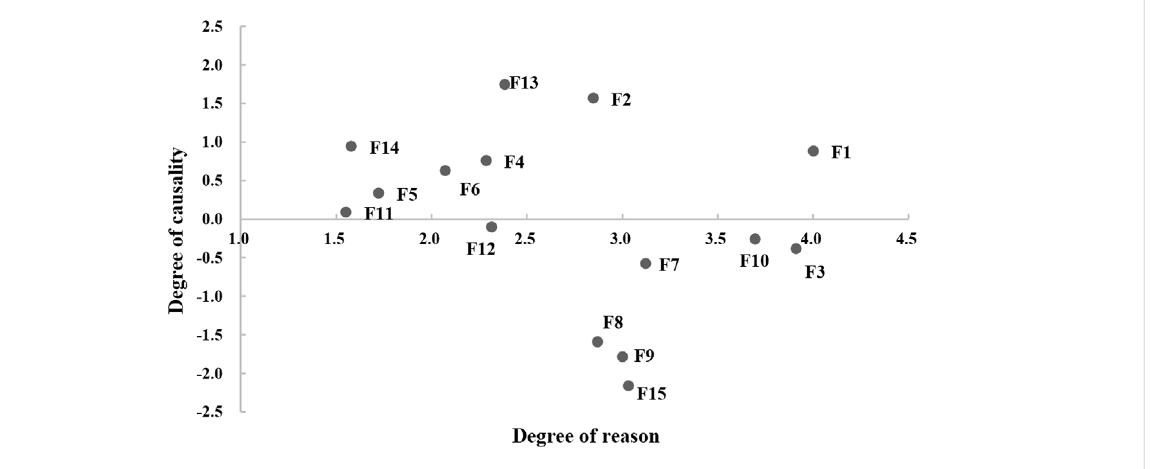
FIGURE 2 Cause-and-effect diagram.